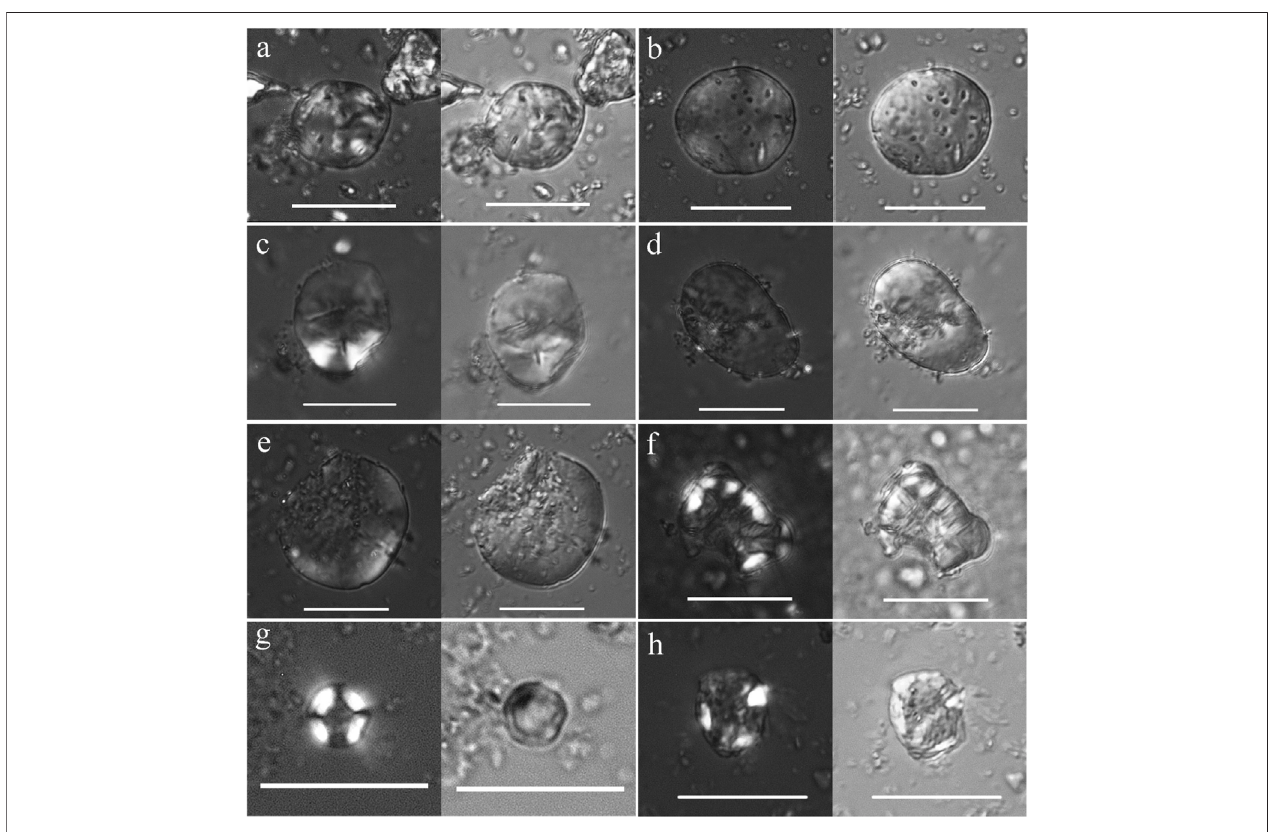
FIGURE 6 | Damaged starch grains from the Qingtai site (scale bar: 20 μ m). (A,B) : showing small pits and cracks, hazy extinction cross; (C) : showing swelling, melting, and hazy extinction cross; (D) : showing pits, melting, and hazy extinction cross; (E) : showing missing edges; (F – H) : showing central depression and swelling.